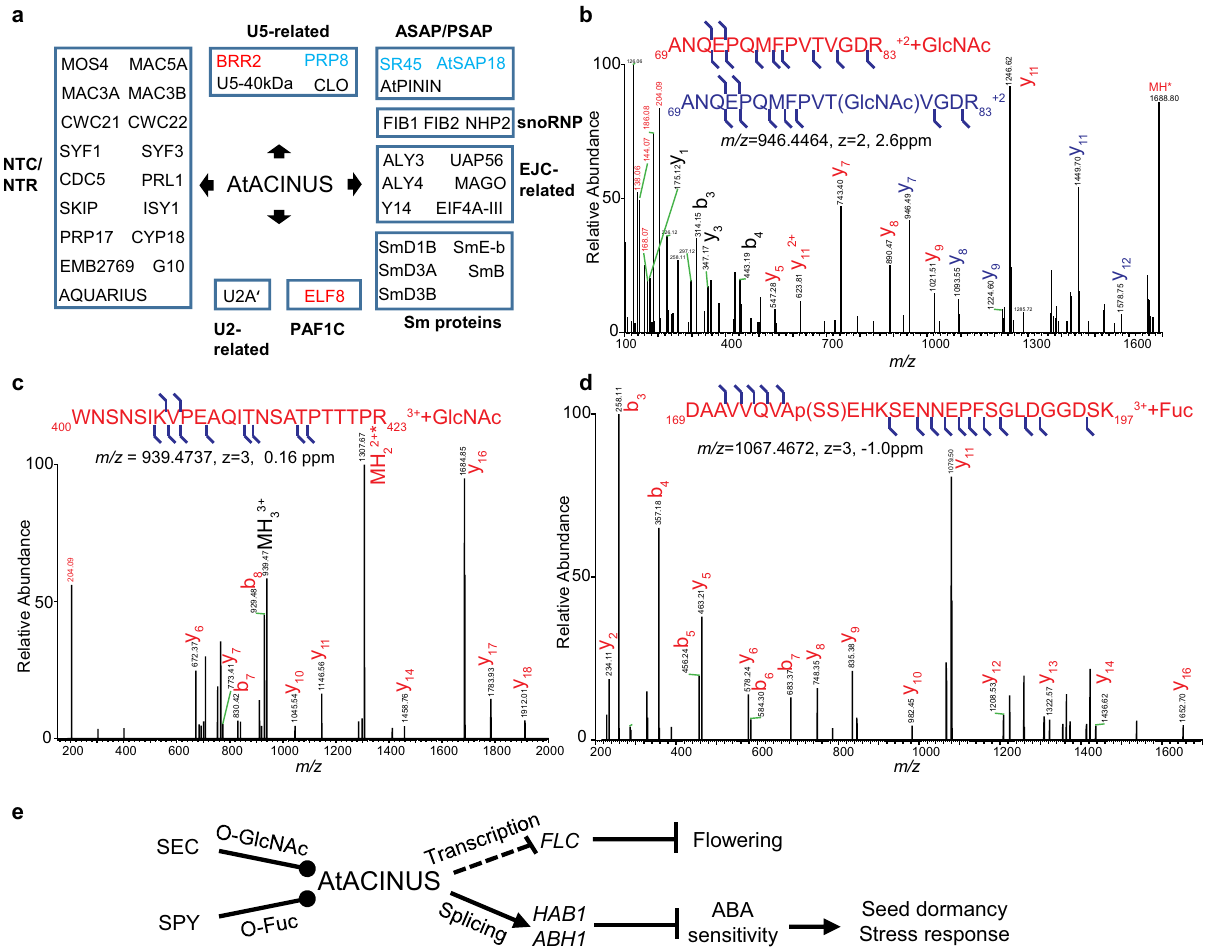
Fig. 7 AtACINUS is O-GlcNAc and O-fucose modi fi ed and associates with spliceosomal complexes, transcriptional regulators, and chromatin remodeling proteins. a Diagram shows functional groups of AtACINUS-associated proteins. Proteins are grouped in boxes based on their association with known complexes or functions. Positive regulators of FLC are highlighted in red and negative regulators in blue. Seven-day-old seedlings were used for the label-free IP-MS experiments and 14-day-old seedlings were used for the 15 N stable-isotope-labeling in Arabidopsis (SILIA) quantitative MS experiments. b , c Higher energy collisional dissociation (HCD) mass spectra show O-GlcNAcylation on Thr79 and a sequence spanning amino acid 400 – 423 of AtACINUS. The sequence ion series that retain this modi fi cation (shifted by 203 Da) are labeled in blue ( b ). The sequence ion series that have lost the modi fi cation are labeled in red. HexNAc oxonium ion ( m/z 204) and its fragments masses are labeled in red. d HCD spectrum shows O-fucosylation on a sequence spanning amino acid 169 – 197 of AtACINUS with neutral loss. e Proposed model of a molecular pathway in which nutrient sensing